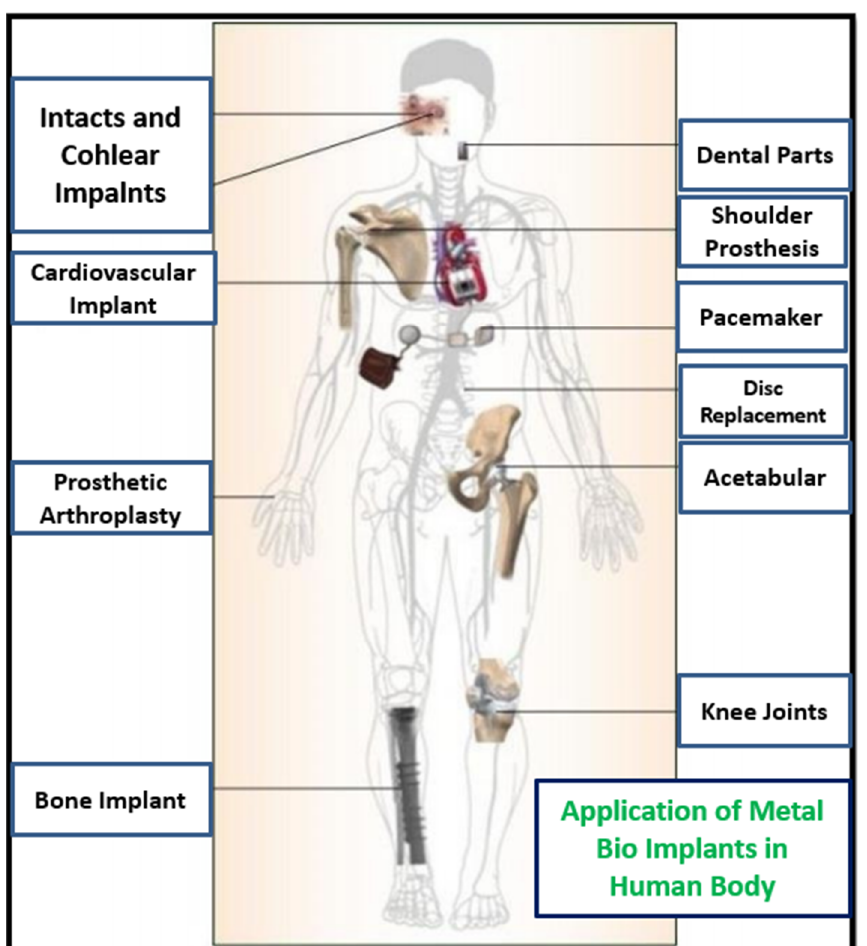
Figure 14. Application of metal bio implant in different areas of the human body [42].